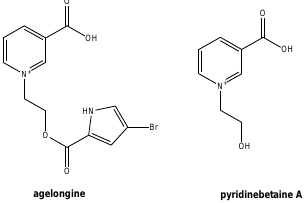
Figure 9. Agelongine and pyridinebetaine A (Cafieri et al .,